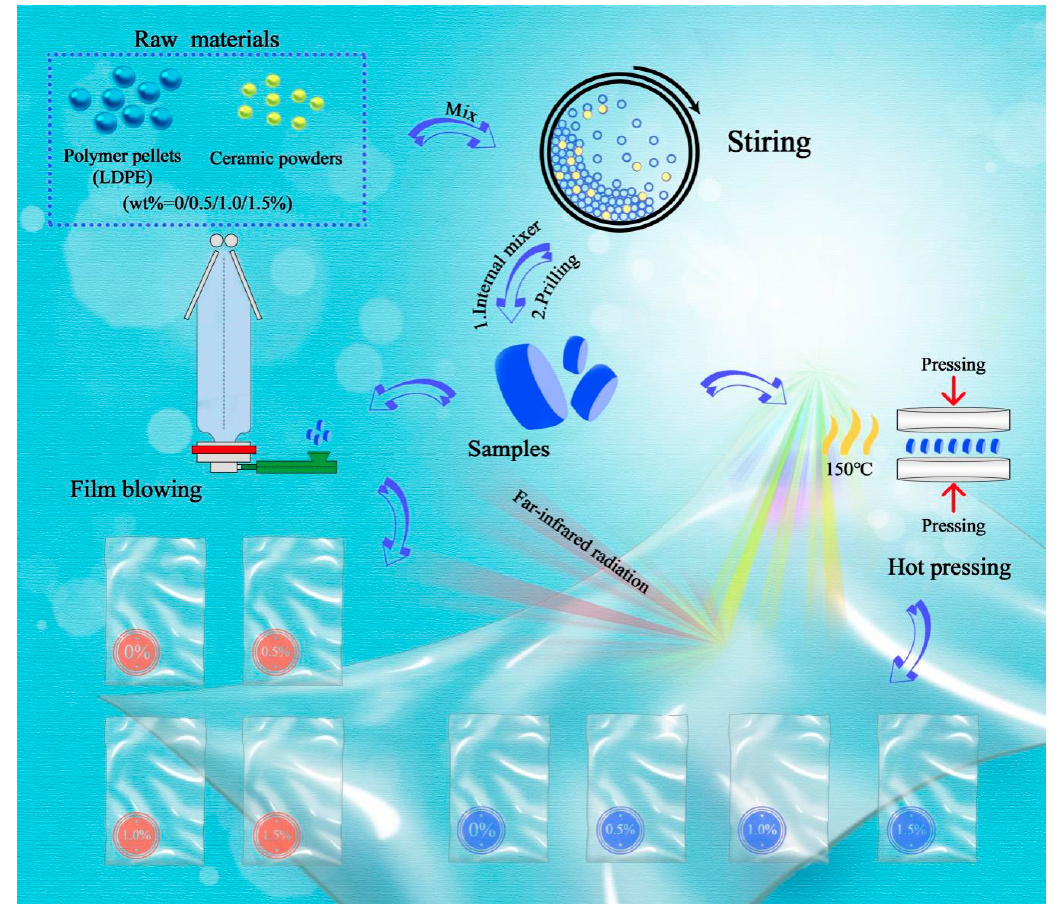
Figure 1. Flow chat of method for making eight different types of composite films.